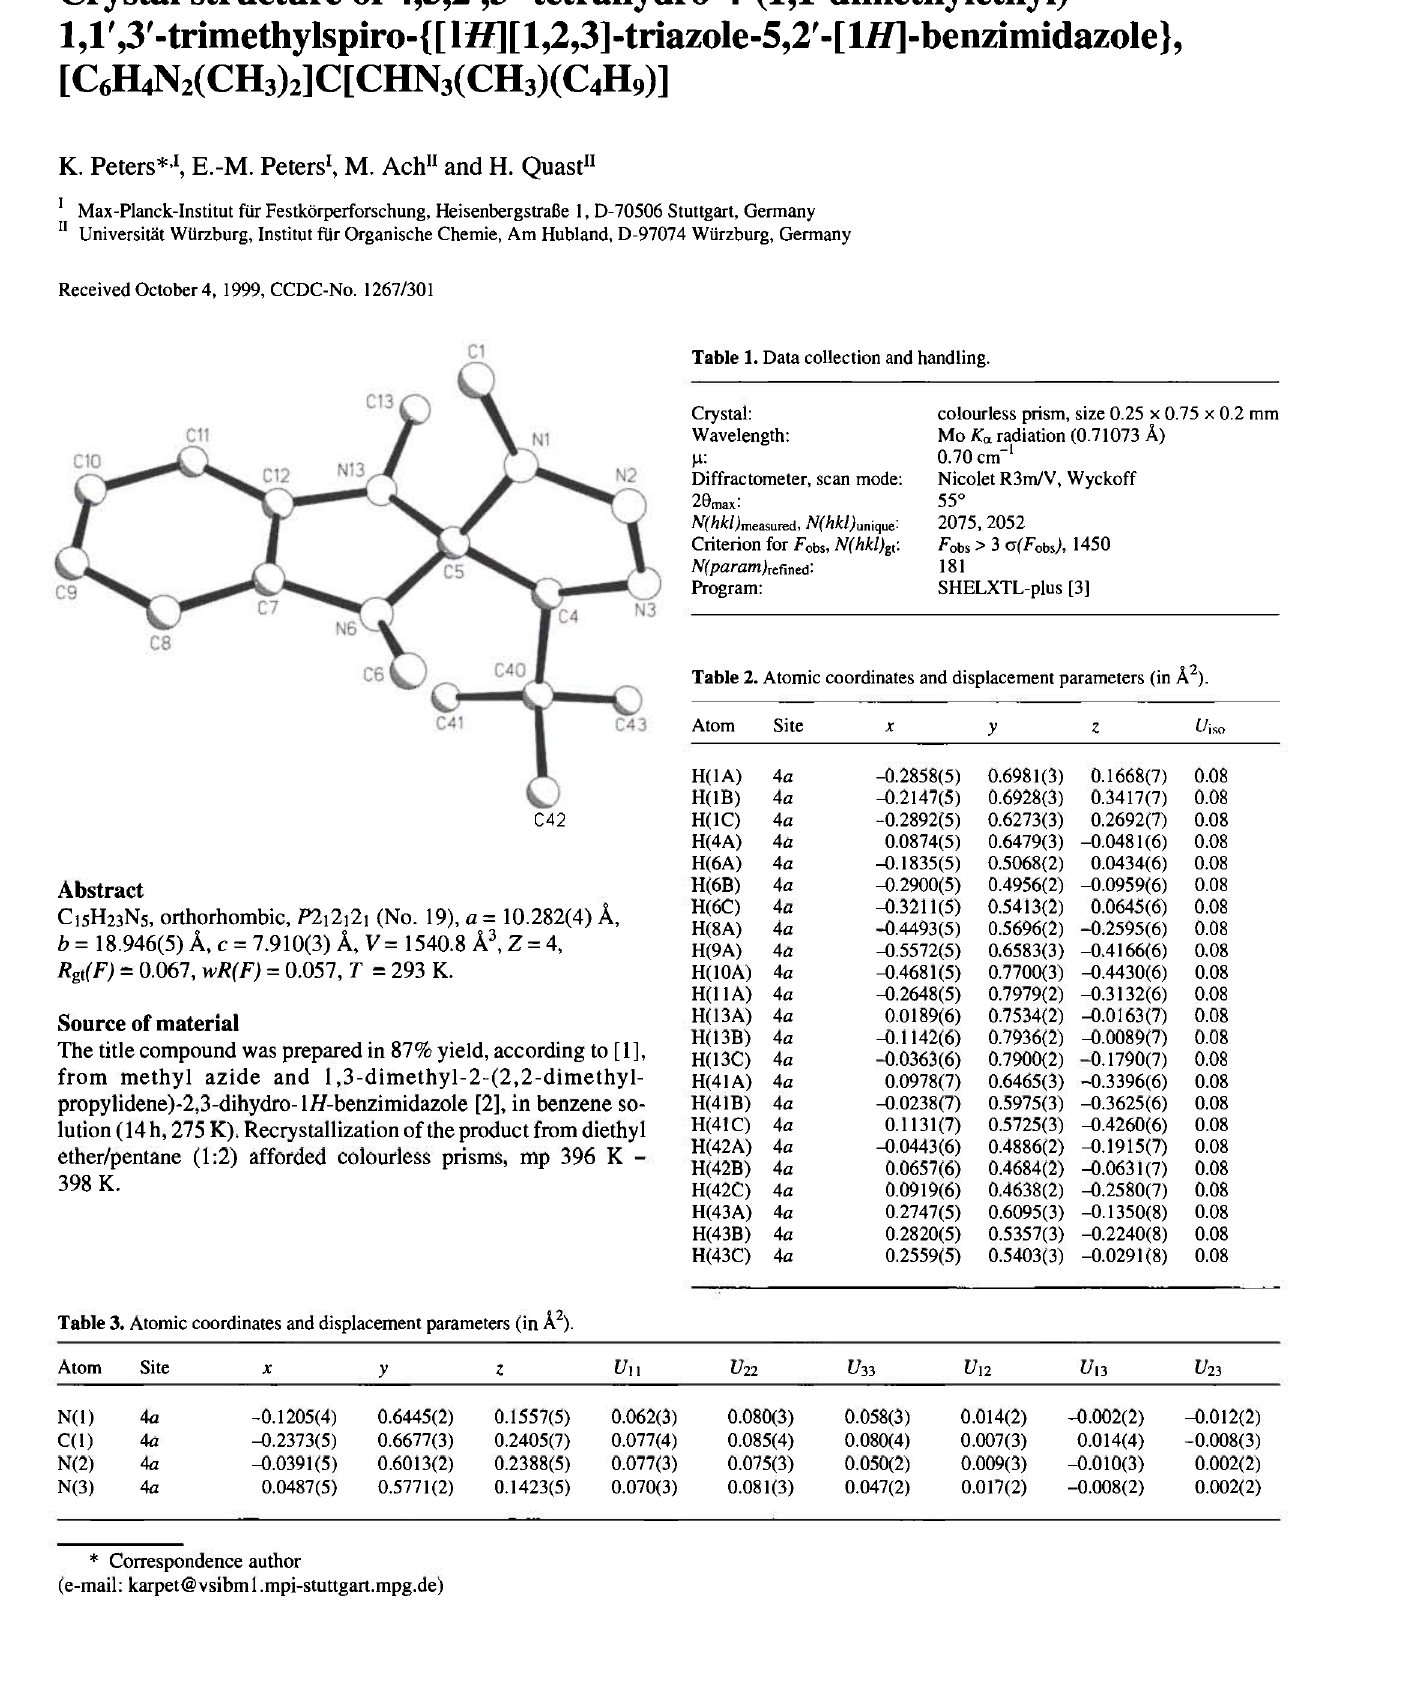
Table 3. Atomic coordinates and displacement parameters (in Ä 2 ).